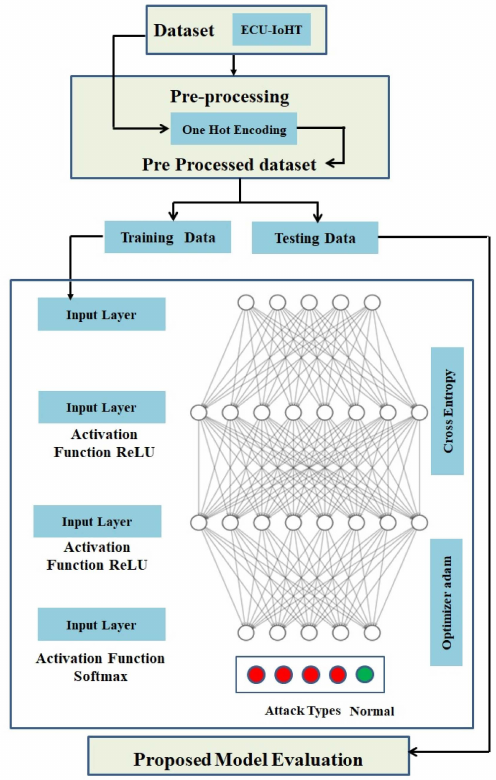
Figure 3. Proposed DNN structure.